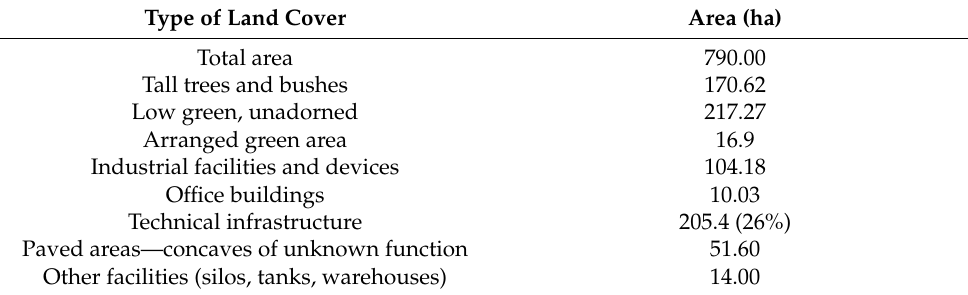
Table 7. Approximate share of land cover in the area of Acelormittal (Combine)